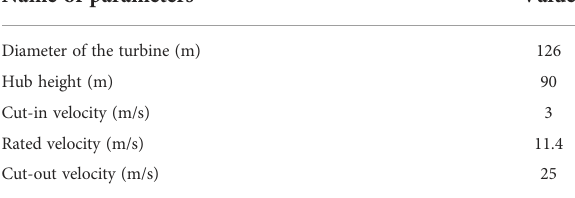
TABLE 5 Parameters of the 5 MW wind turbine.